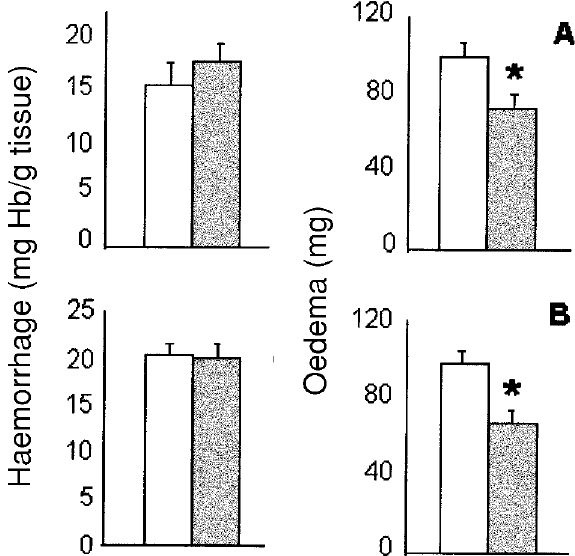
FIG. 3. Effect of treatments with (A) dexamethasone and (B) indomethacin on B. jararaca -induced haemorrhage and oedema. Mice treated with (A) dexamethasone (1 and 0.4mg/kg, i.p., 24 and 1h before the venom) or (B) indomethacin (30mg/kg,s.c., 30min before the venom) received 5 m g of B. jararaca venom into the foot pad. Haemorrhage and oedema in treated animals (dark bars) were compared with results obtained in saline treated control groups (white bars). Mean ± SE. * p <